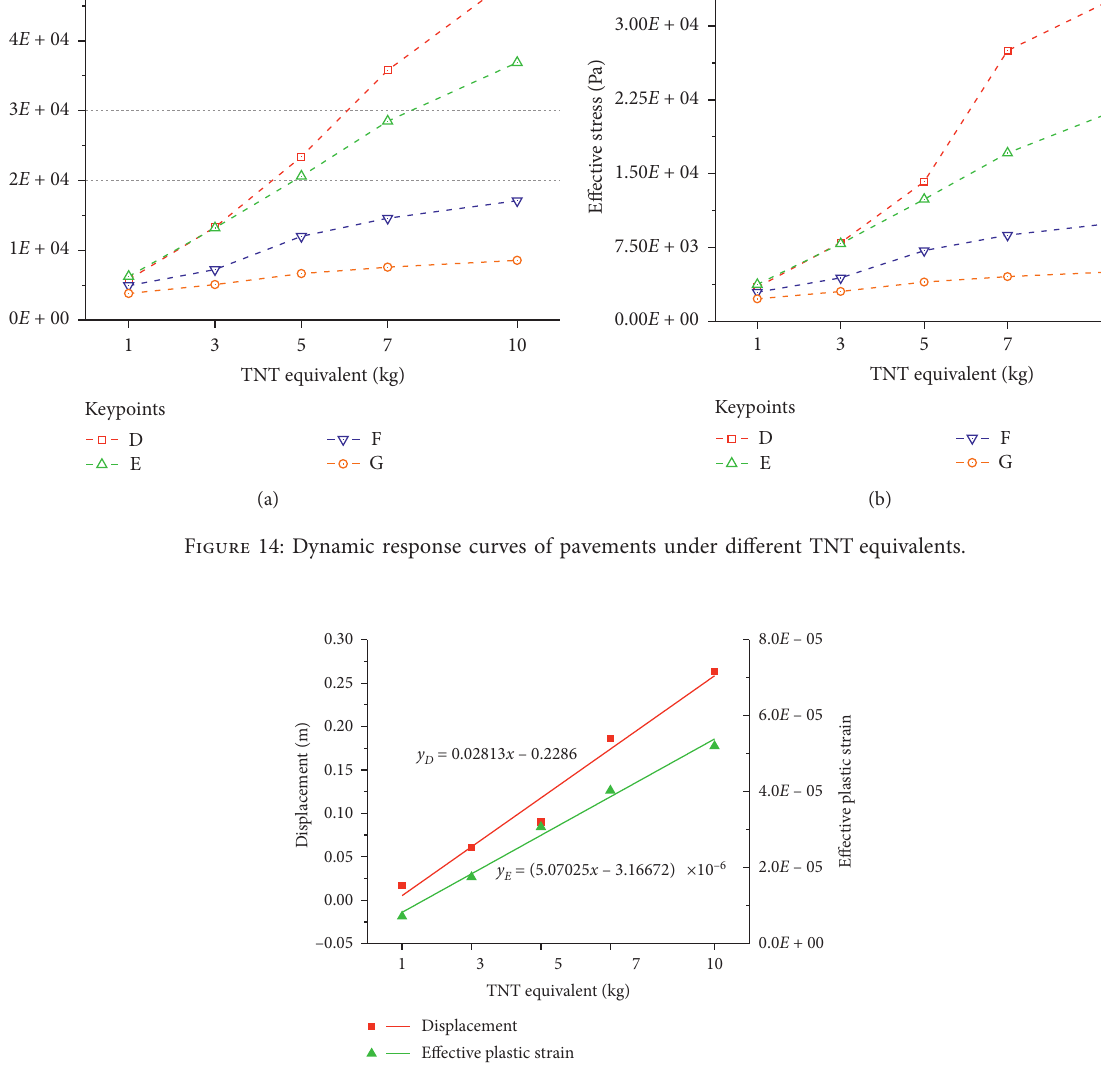
Figure 15: Deformation of pavements under different TNT equivalents.